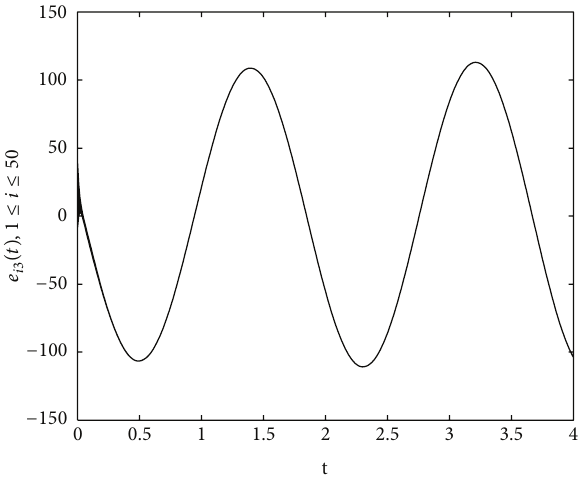
Figure 14: Synchronization errors 𝑒 𝑖 1 , 1 ≤ 𝑖 ≤ 50, with no control input.